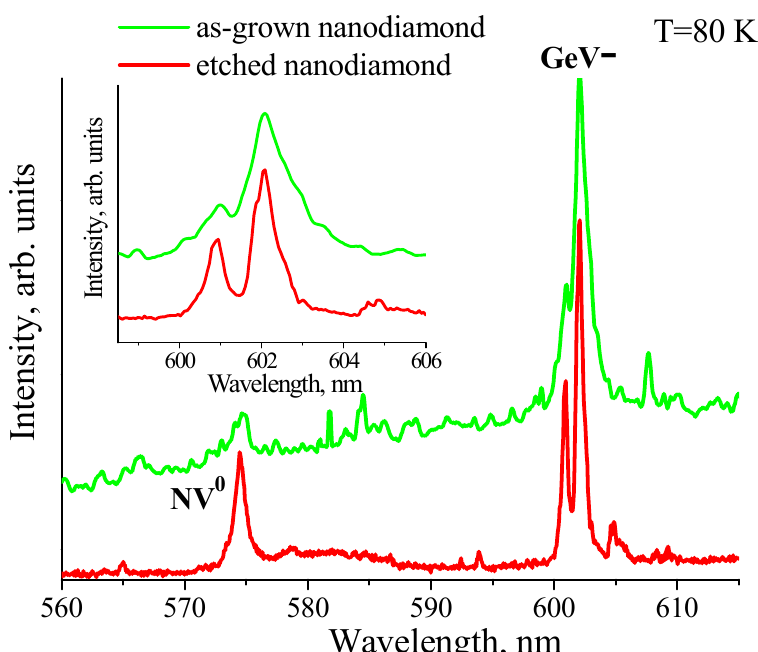
Figure 3. Typical photoluminescence spectra of as-grown nanodiamonds and etched nanodiamonds, measured at T = 80 K. The inset shows in detail a part of the photoluminescence spectra in the vicinity of the ZPL of GeV − color centers. The attribution of the luminescence lines to different color centers is indicated (GeV − and NV 0 ).